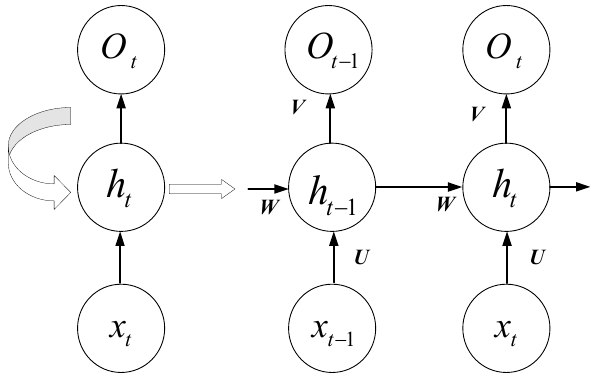
Figure 6. RNN structure diagram.